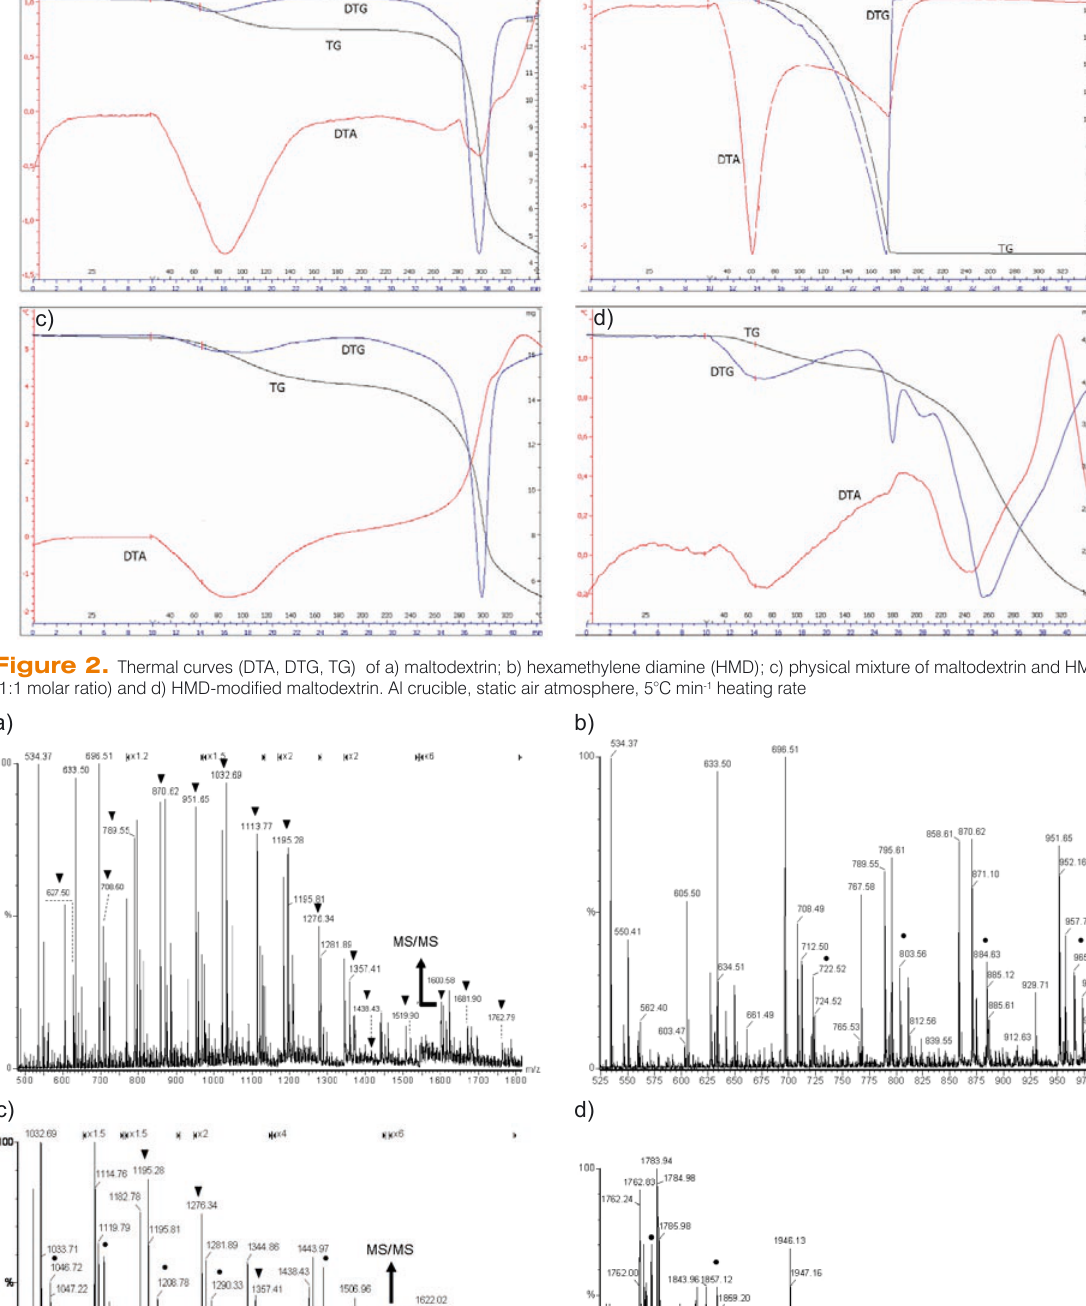
GHD series; ● - products resulting from a n